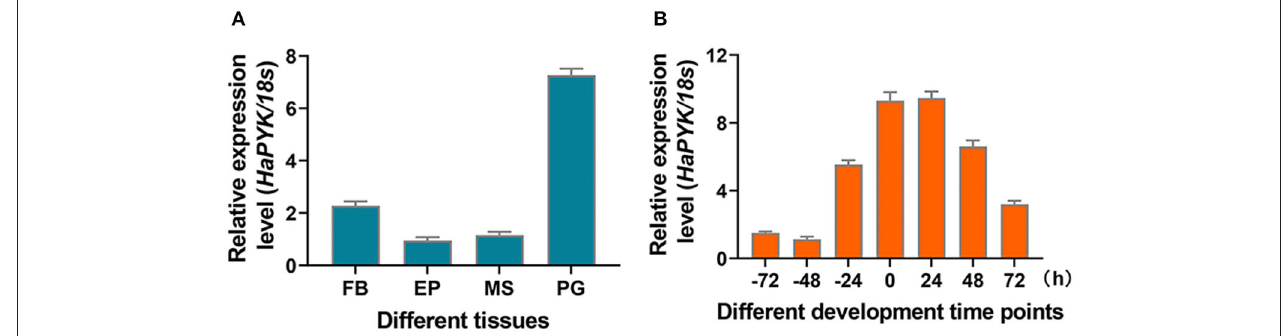
FIGURE 1 | The expression profile of HaPYK . (A) The tissue distribution of HaPYK by qRT-PCR. FB, fat body; EP, epidermis; MS, muscle; PG, pheromone gland. (B) The expression profile of HaPYK in the PGs by qRT-PCR. Newly-emerged adult was designated as 0 h-old adult. The 18S was used as the internal reference. Error bars indicated the mean ± s.d. of three independent biological experiments and three technical repetitions.